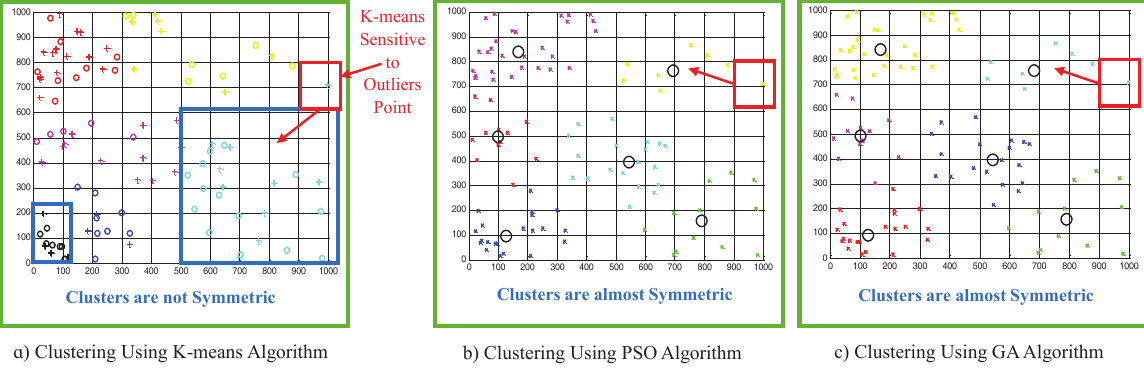
Figure 4. Clustering results using ( a ) K -means, ( b ) PSO-based and ( c ) GA-based clustering algorithms.